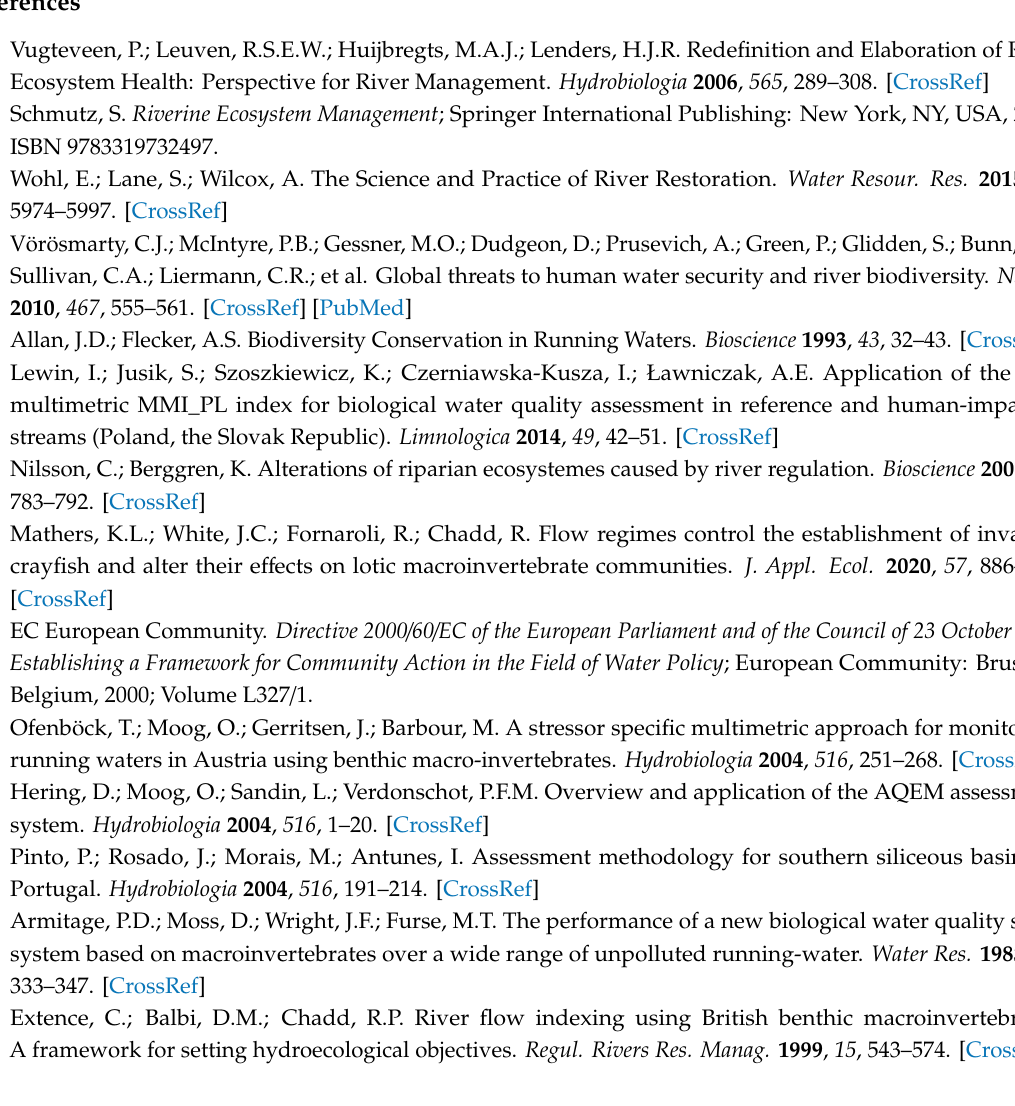
Table S1: Macroinvertebrate functional traits examined within this study, with biological traits in non-italicized text and ecological traits being italicized, Figure S1: Distribution of pristine and altered sites along the geographic gradients, Figure S2: Results of variance partitioning on macroinvertebrate metrics and indices. Values displayed are the adjusted R 2 and negative values are not shown. The unexplained portion is shown in the bottom right of panels (Residuals), Figure S3: Temporal trajectories of (a–c) log 10 transformed Nemouridae absolute abundance, (d–f) log 10 transformed Heptageniidae absolute abundance, (g–i) log 10 transformed Limnephilidae absolute abundance and (j–l) Functional Richness visualized using LOESS (Locally Estimated Scatterplot Smoothing) for the di ff erent